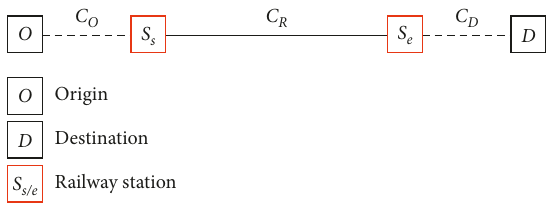
Figure 1: Structural sketch of passenger fare